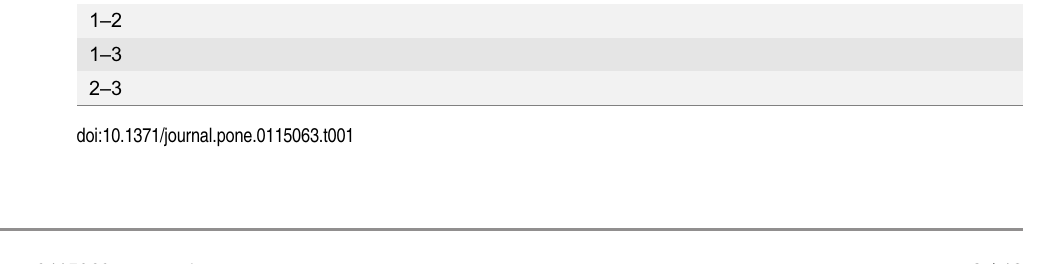
Table 1. Example of connections for a multinational study carried out in country 1, 2, and